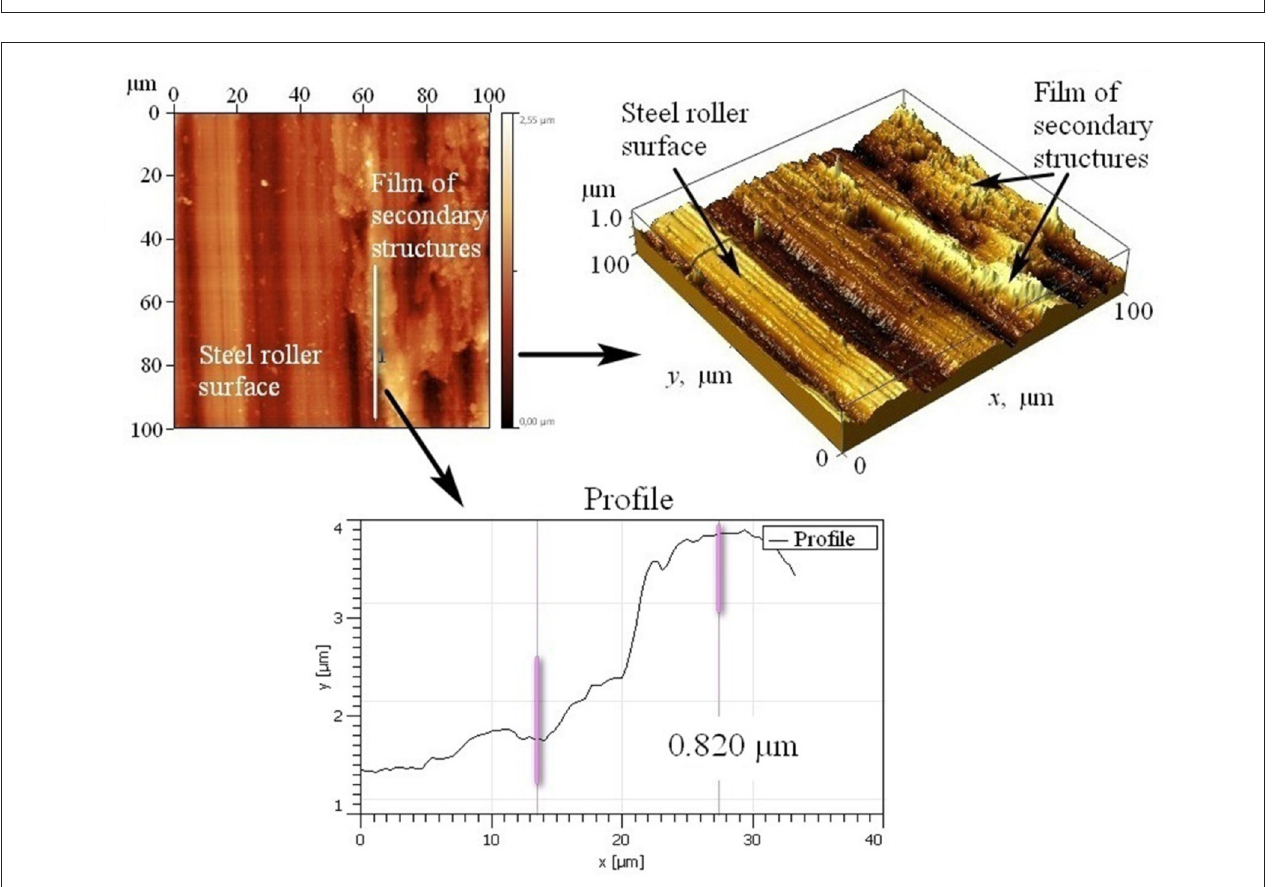
FIGURE 4 | SPM image of individual areas of the roller surface after tribological tests; profile of the section line.